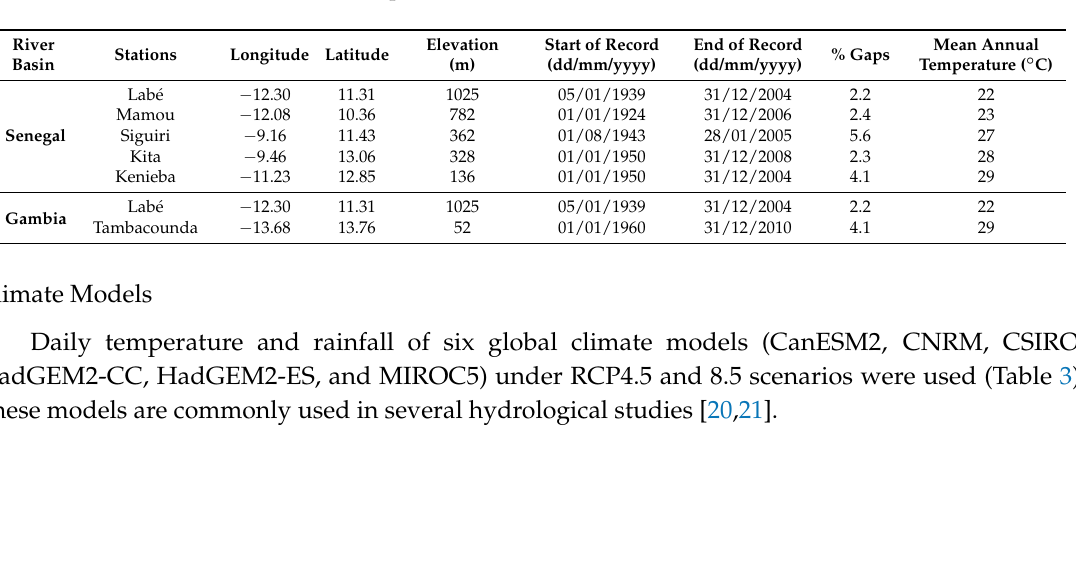
Table 2. Temperature stations for the two river